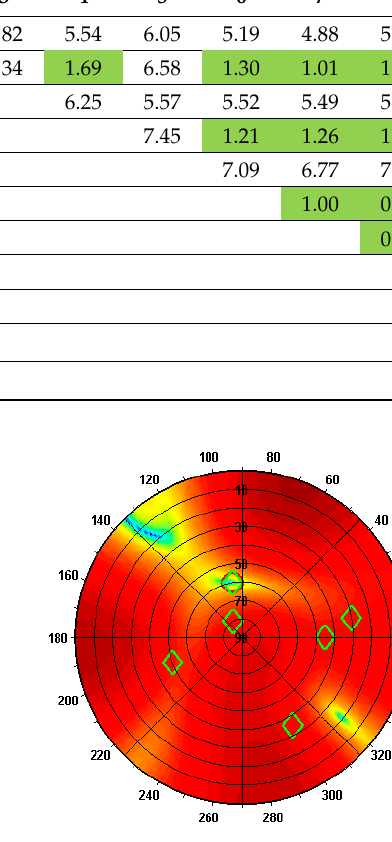
Figure 11. Reception pattern of antenna array in spoofing scenario 2.